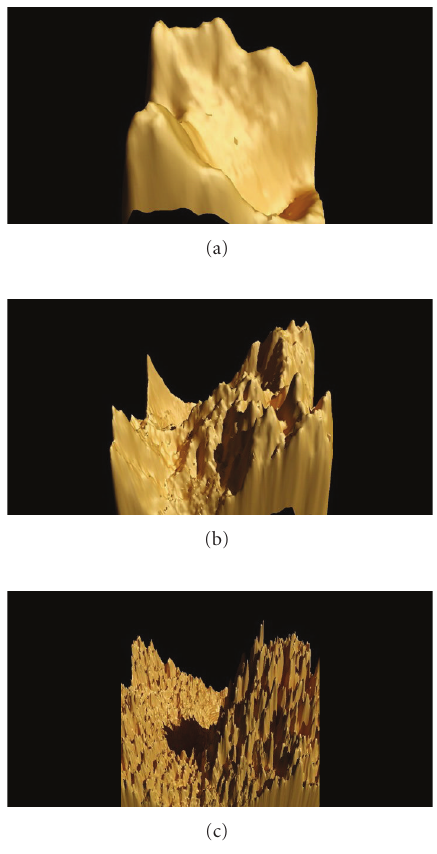
Figure 15: Volcanoes generated by TP in (7), with resolutions 50 × 50, 150 × 150, and 450 ×